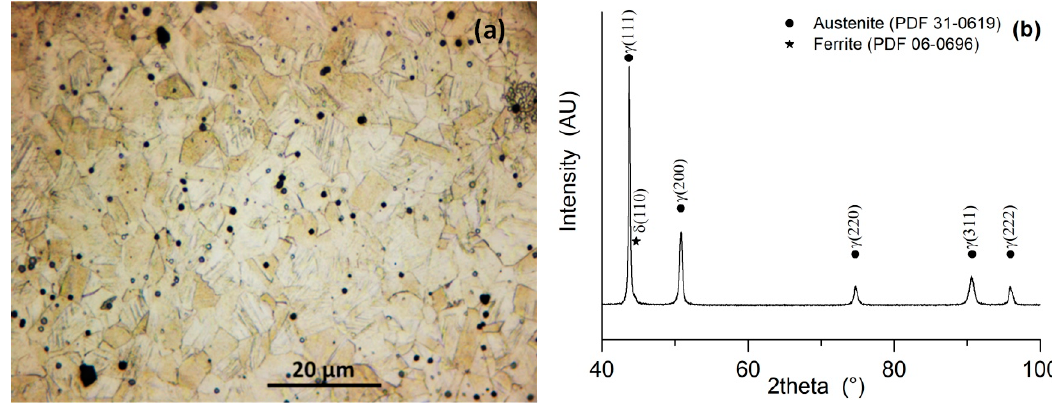
Figure 2. Microstructure ( a ) and XRD patterns ( b ) of AISI 304L stainless steel, previous to wear tests.